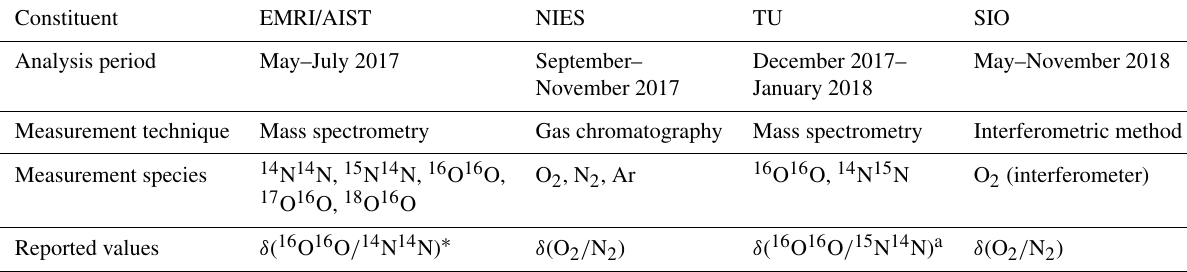
Table 2. Measurement techniques, measurement species, and reported values of EMRI/AIST, NIES, TU, and